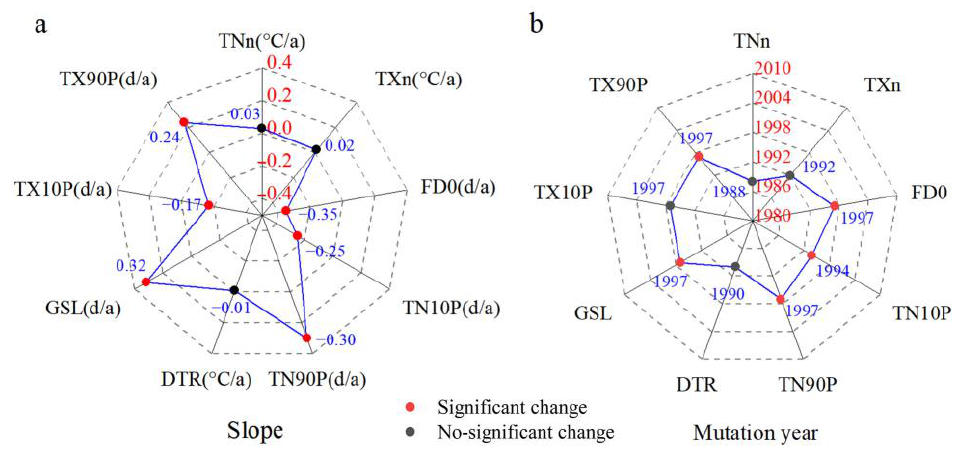
Figure 4. Trends ( a ) and abrupt years ( b ) of extreme temperature indices in the Beijing–Tianjin–Hebei region from 1980 to 2019 (confidence level 95%).